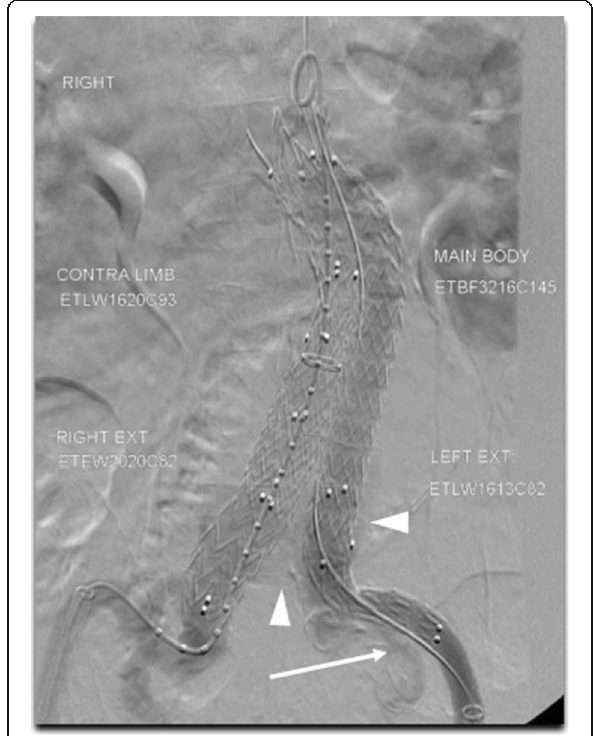
Fig. 1 Static image from angiogram post stent graft deployment. Arrowheads demonstrate type II endoleak within the aneurysm sac. Arrow demonstrates patent left IIA